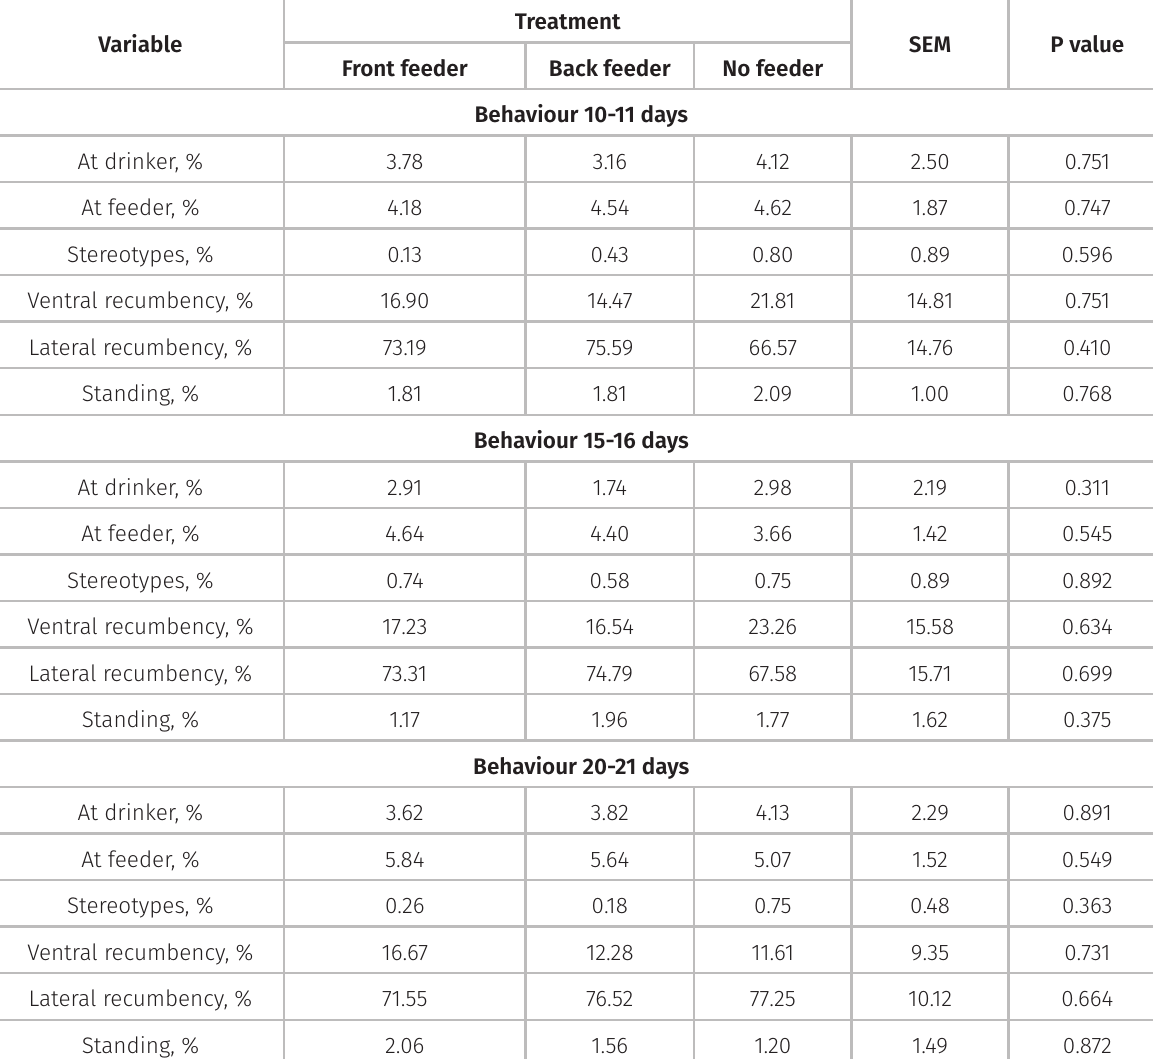
Table III. Sows behaviour at 10-11, 15-16, and 20-21 days after farrowing with different positions of piglet feeder on the farrowing crate or without piglet